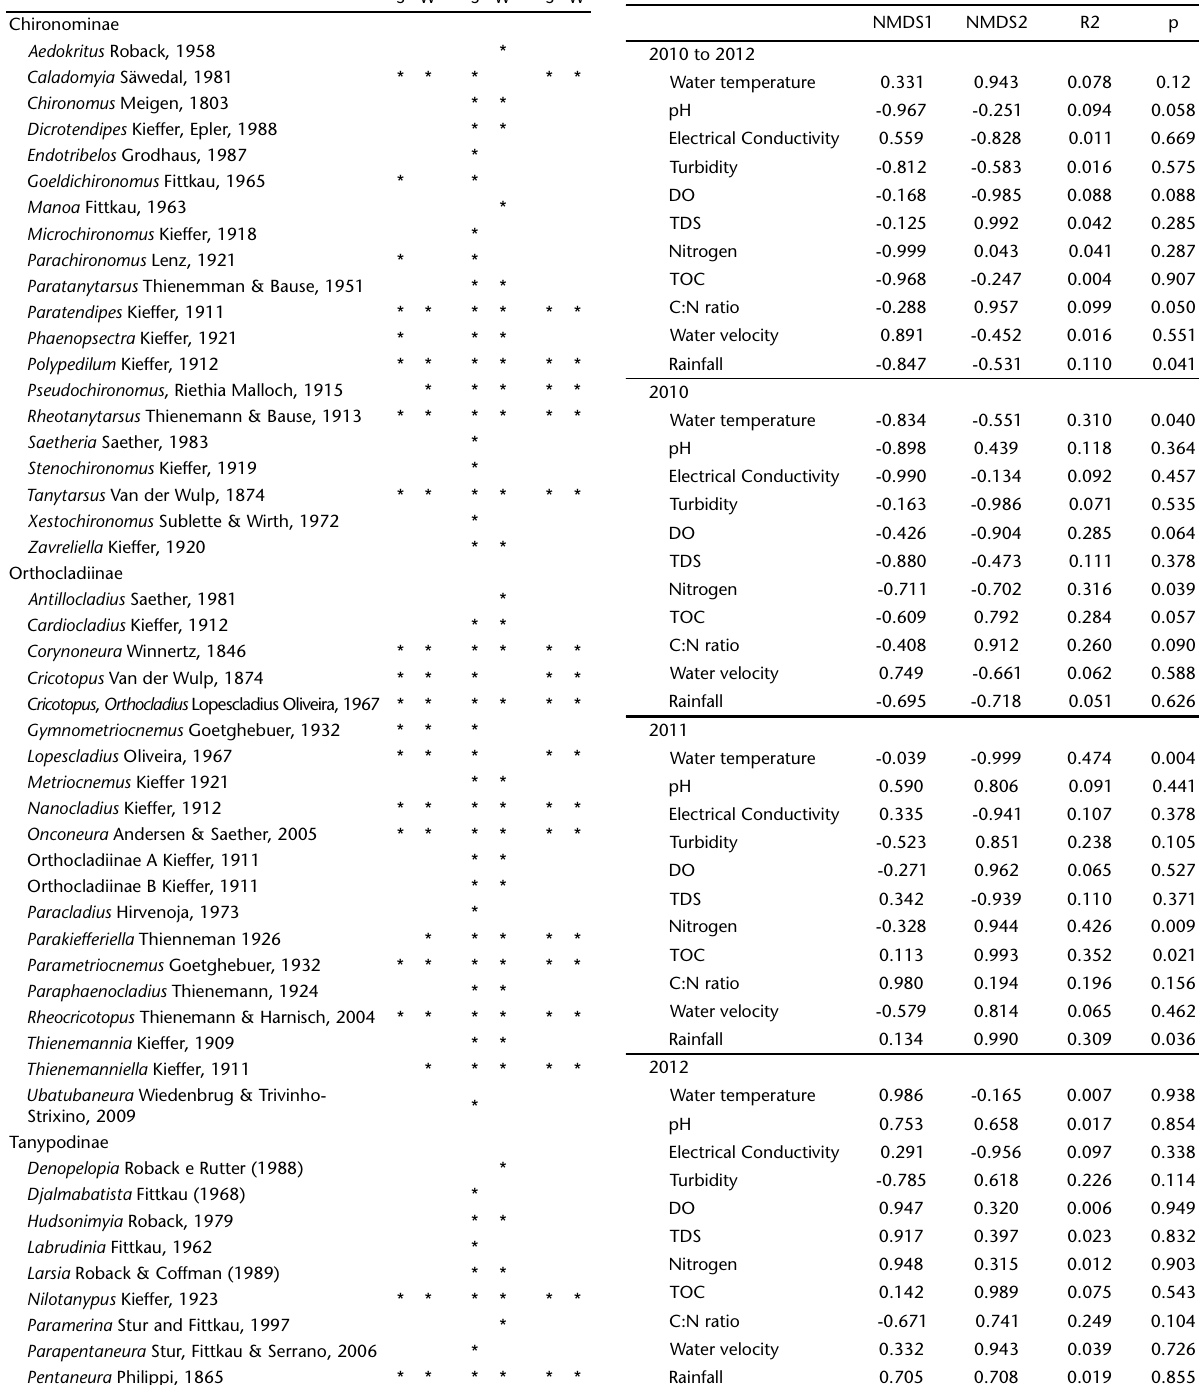
Table 5. Analysis of the structure between the abiotic data and the biological matrix (NMDS), inter- and intra-annual variation tested from the non-parametric multivariate analysis in subtropical